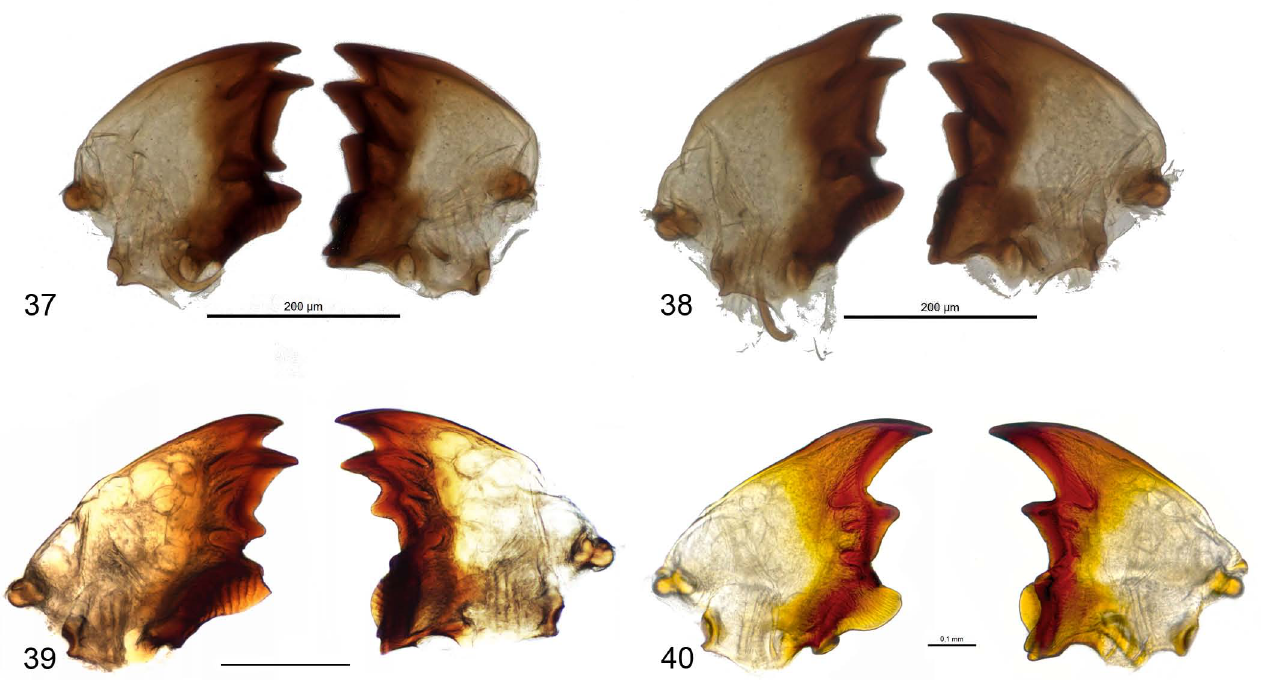
Figs 37–40. Worker mandibles in dorsal view: 37- Diversitermes diversimiles , narrow gap; 38- Diversitermes diversimiles , broad gap; 39- Caetetermes taquarussu , broad gap; 40- Tiunatermes mariuzani